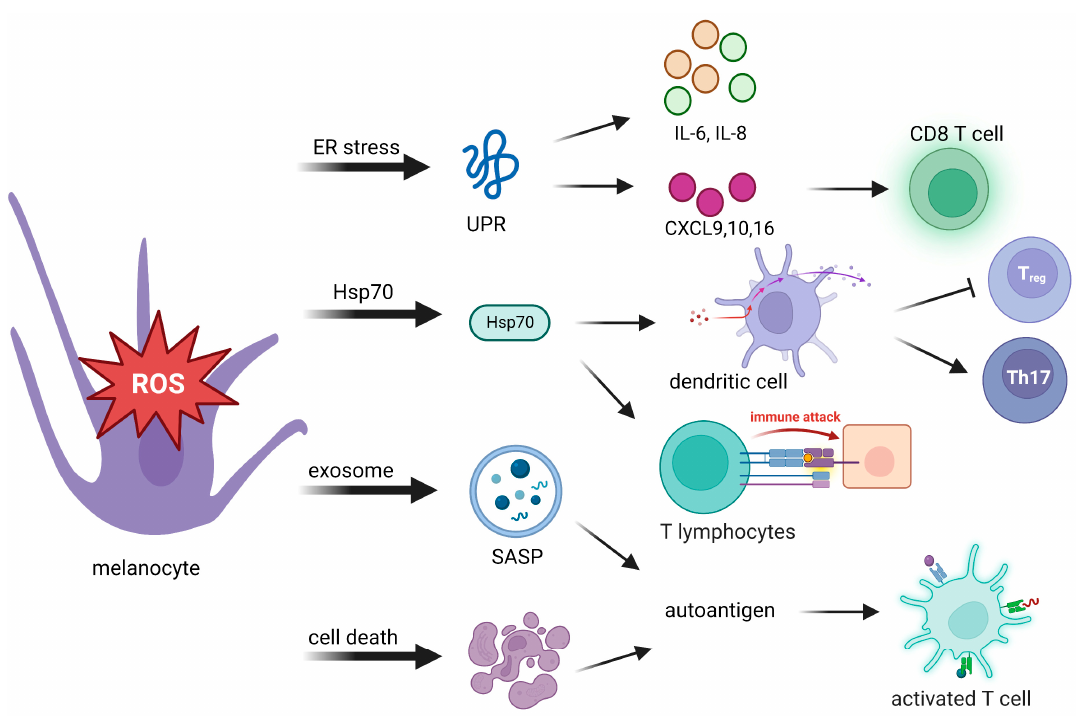
Figure 2. Oxidative stress activates adaptive immunity through autoantigen presentation to innate immunity. Stressed melanocytes produce autoantigens in the manner of cytokines, extracellular exo- somes, and cell death debris. Autoantigens can be highly immunogenic, which activates cytotoxic T cells, regulatory T (T reg ) cells, and T helper cells. UPR, unfolded protein response; IL-6, interleukin- 6; IL-8, interleukin-8; CXCL, C-X-C chemokine ligand; Hsp70, 70-kDa heat shock protein; SASP, senescence-associated secretory phenotype; Th17: T helper 17.